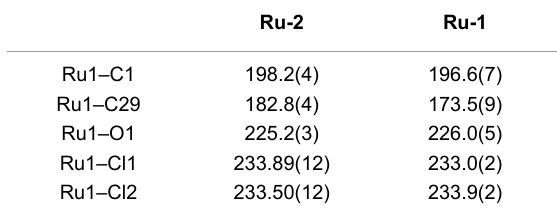
Table 1: Selected bond lengths (pm) for Ru-2 and Ru-1 [21].